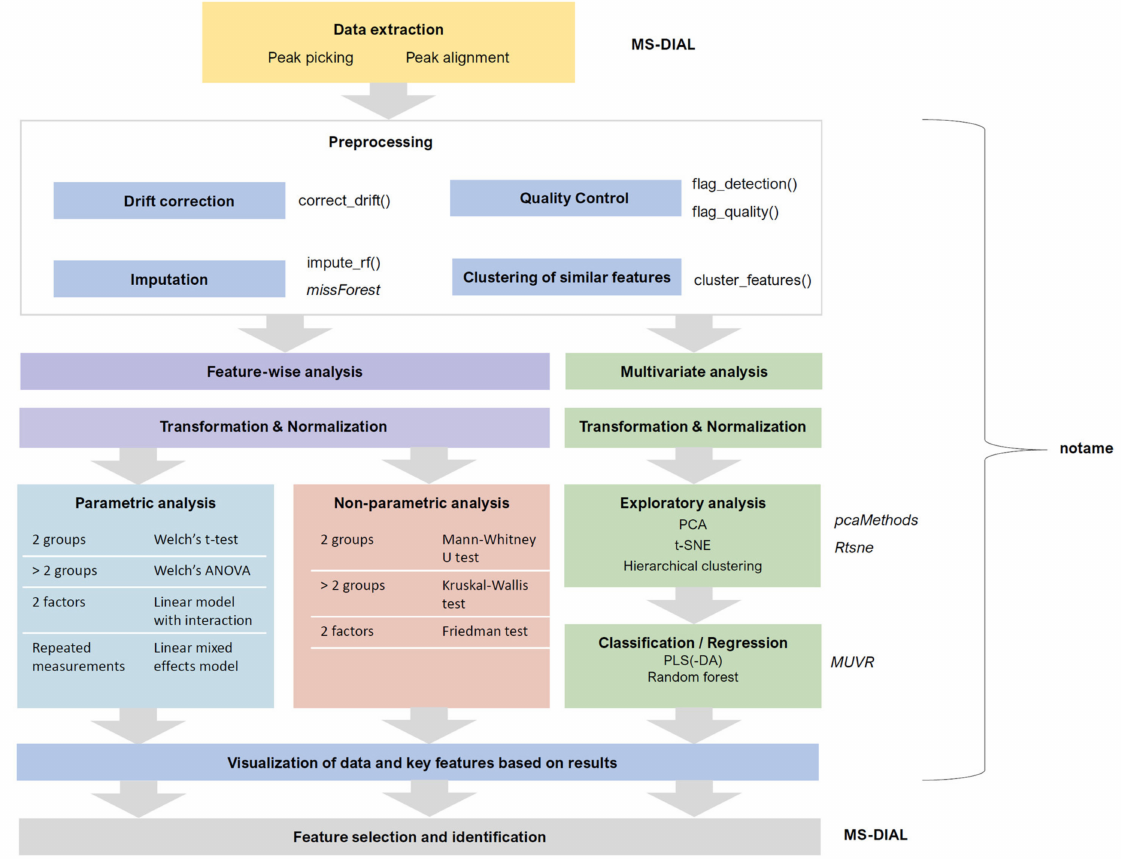
Figure 2. Workflow of the statistical analysis after the peak-picking step. The choices depend on the type of data, the research question and the study design. The tools used for specific steps are listed on the right side of the respective steps. Italicized names are names of external R packages, names ending with () are major functions from the notame package. For more details, see the package